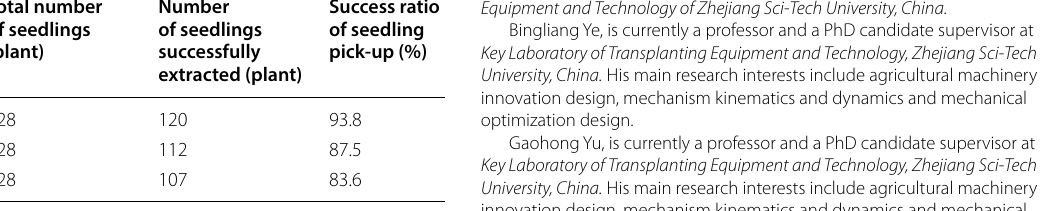
and eccentric distance of the incomplete eccentric circular gear ( R 28 mm and e 3.3 mm, respec- = = tively), the central angle corresponding to the pitch curve of the toothed part of the incomplete eccen- tric circular gear β 288°, the central angle corre- = sponding to the pitch curve of the meshing part of the middle non-circular gear with the incomplete eccentric circular gear α 323°, the initial rota- = tion angle of the incomplete eccentric circular gear θ 30°, the initial installation angle of the seed- = ling pick-up mechanism ϕ 0 65°, the installation =